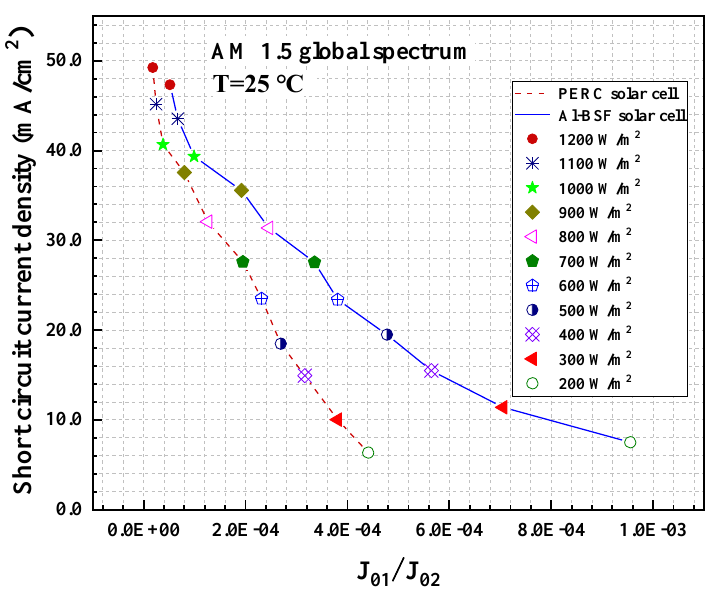
Figure 9. E ff ect of the J 01 / J 02 ratio on short-circuit current density ( J sc ) for PERC and Al-BSF silicon solar cells under di ff erent injection levels. Figure 9. Effect of the J 01 /J 02 ratio on short-circuit current density (J sc ) for PERC and Al-BSF silicon solar cells under different injection levels.